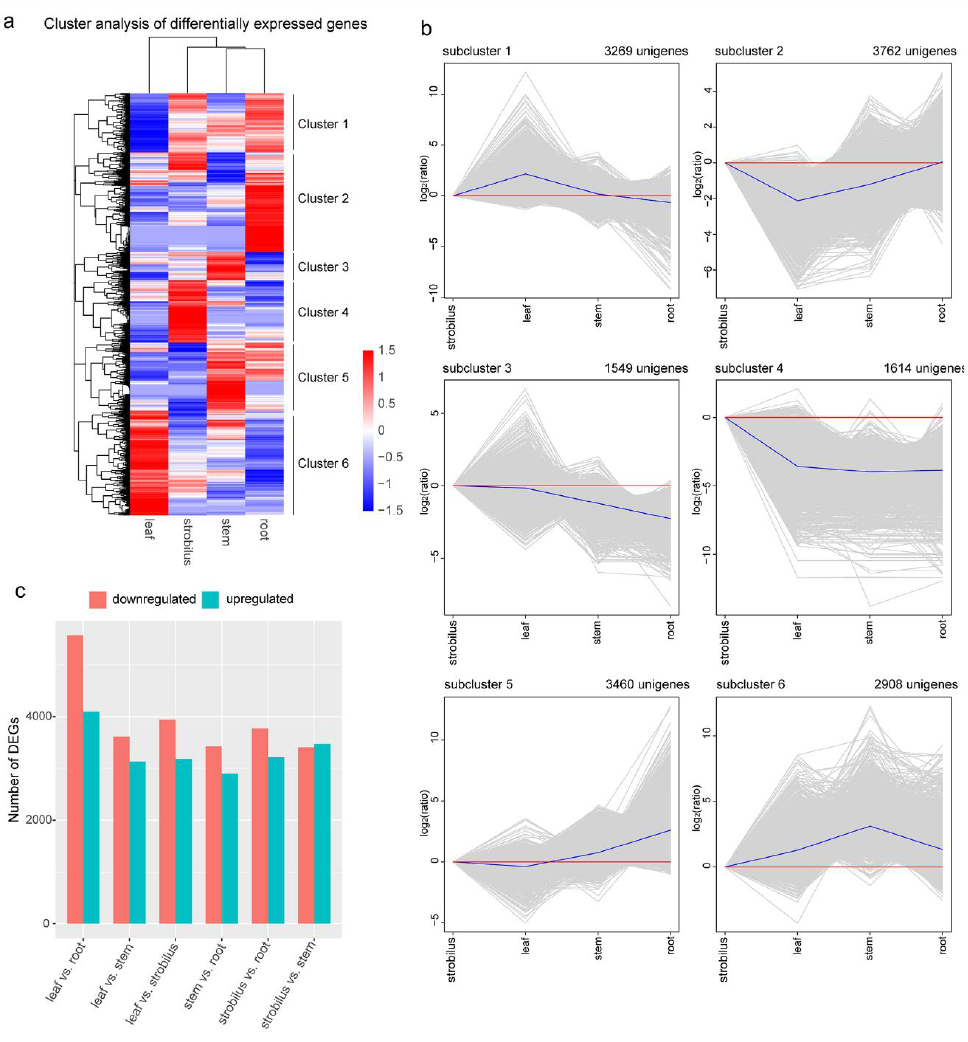
Figure 6. Differentially expressed genes (DEGs) among four organs of P. chienii . ( a ) A heatmap of the expression patterns of 16,562 DEGs. A scale indicates the color assigned to log 10 (FPKM + 1). Red indicates high expression, and blue indicates low expression. ( b ) The six subclusters of the 16,562 DEGs were clustered. The number of unigenes in each subcluster is shown at the top of the subcluster. The red lines represent the gene expression level of the strobilus. The blue line shows the average values of the relative expression levels in each subcluster, and the gray lines represent the relative expression levels of each unigene. ( c ) The number of upregulated and downregulated unigenes for leaf vs. strobilus, leaf vs. root, leaf vs. stem, strobilus vs. root, strobilus vs. stem, and stem vs. root.